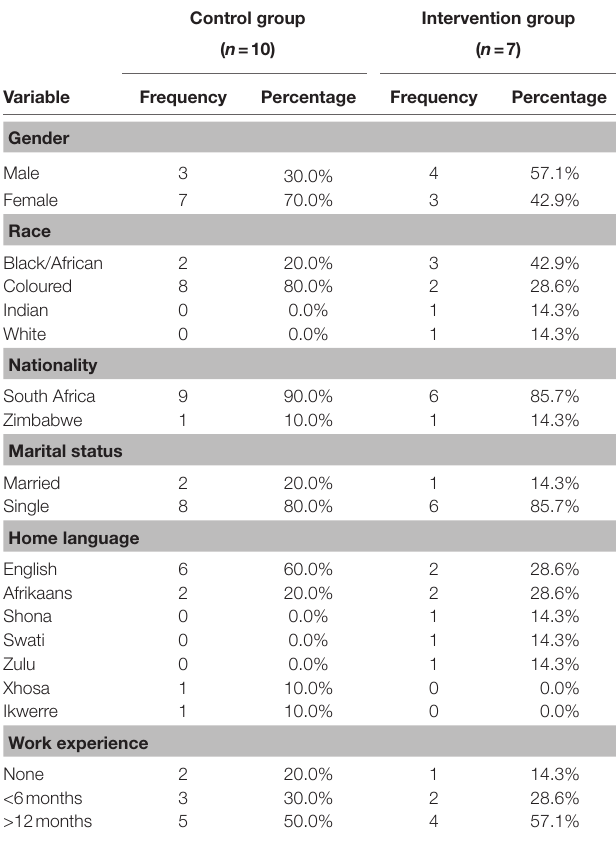
TABLE 1 | Sample sociodemographic